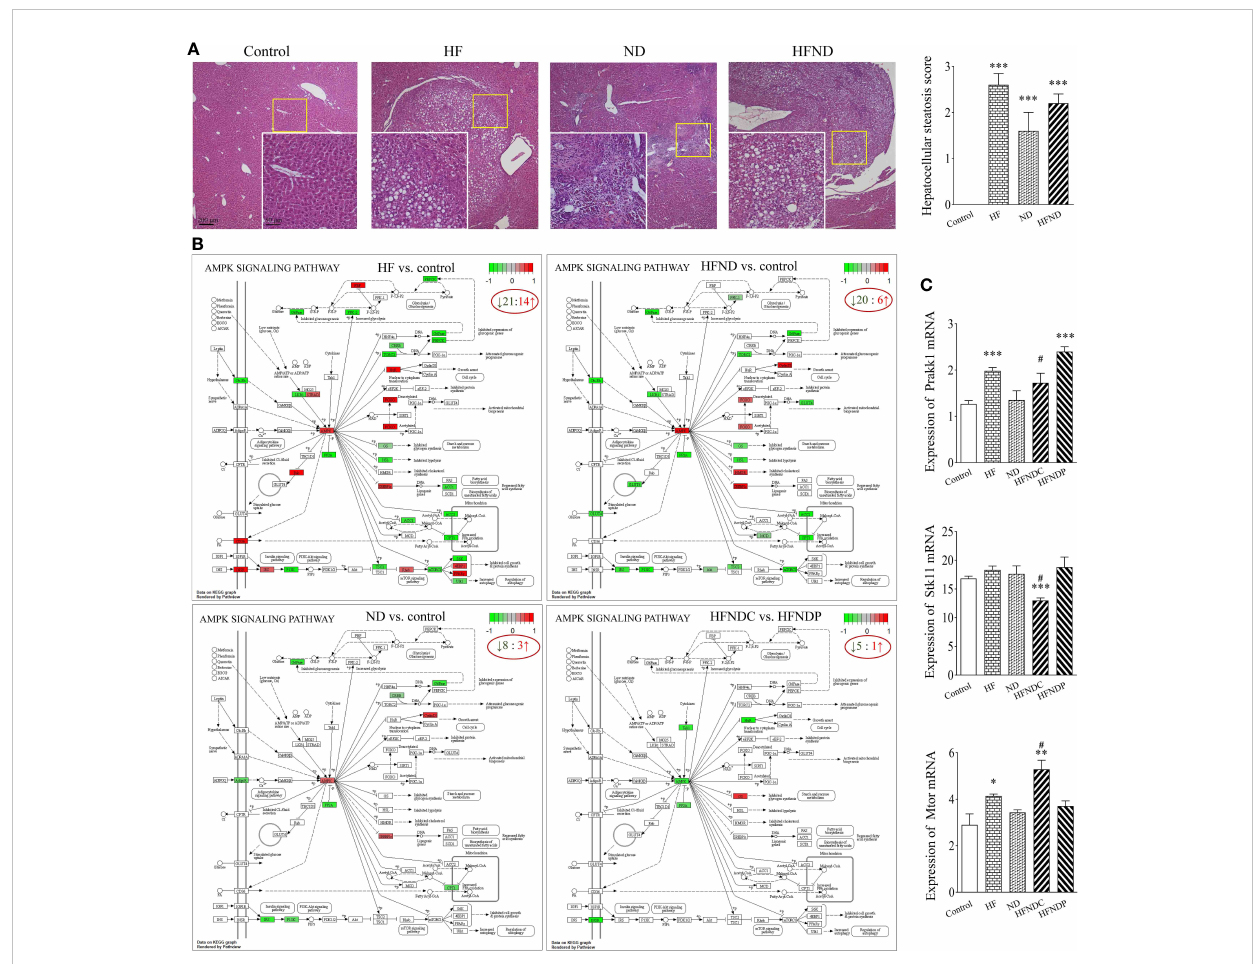
FIGURE 1 General view of mouse livers and KEGG pathways: AMPK signaling pathway and mRNA expression of Prakk1 , Stk11 , and Mtor . (A) General view of the liver samples and Hepatocellular steatosis score. (B) KEGG pathways: Changes in AMPK signaling pathway genes in different groups. (C) Statistical quanti fi cation of the mRNA levels of Prakk1 , Stk11 , and Mtor in the livers of mice. Upregulated genes are marked in red, and downregulated genes are marked in green. The experimental data are expressed as the mean ± SEM. Compared to the control, * p < 0.05; ** p < 0.01; *** p < 0.001. Compared to HFNDP, # p < 0.05. Scale bar, 50 µm and 200